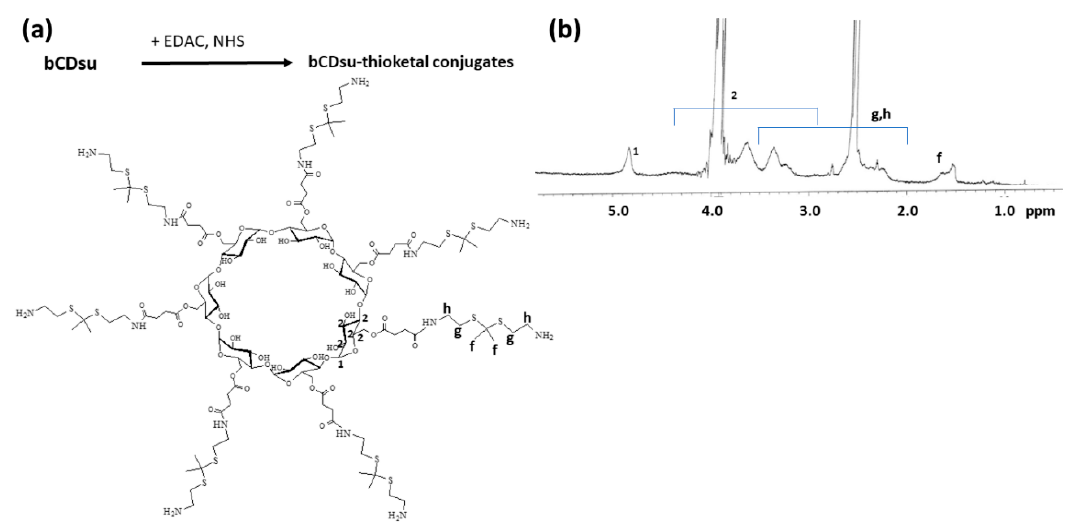
Figure 1. ( a ) Synthesis scheme and ( b ) 1 H NMR spectra of bCD-thioketal amine. To measure chemical structure with 1 H NMR spectroscopy, bCDsu-thioketal amine was dissolved in dimethyl sulfoxide (DMSO)-d form. bCDsu, the 1 H NMR spectra of bCDsu and thioketal diamine are shown in Figure S1.